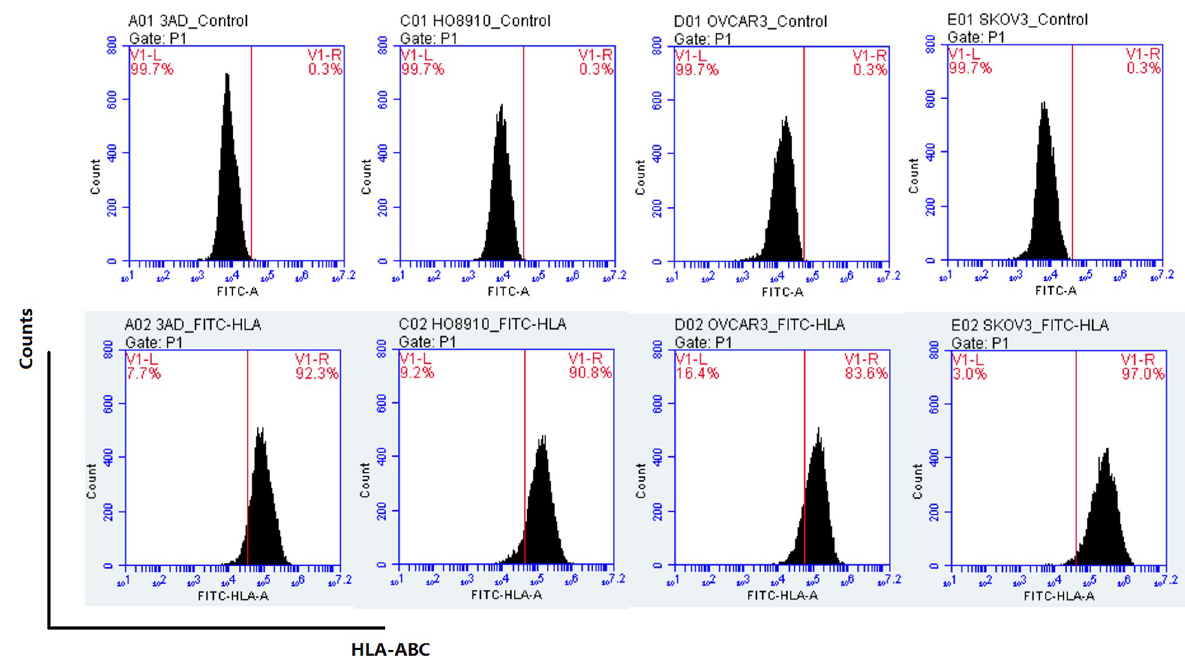
Fig 5. Detection of the binding capability of ovarian cancer cell surfaceNKG2DL with NKG2D receptor with NKG2D-Fc recombinant protein. The upper panel shows the control without additionof NKG2D-Fc recombinant protein.